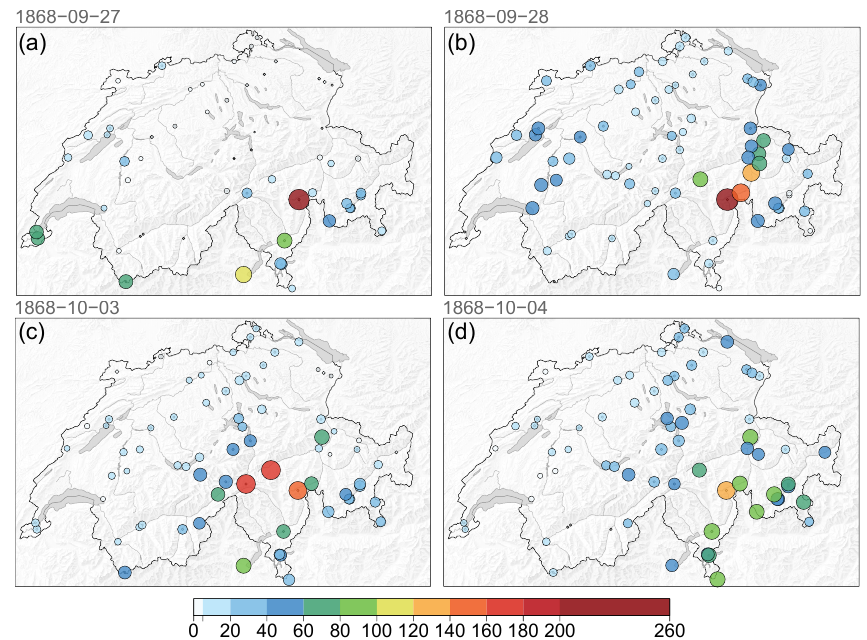
Figure 5. Observations of daily precipitation (mm24h − 1 from 05:40 LT) for (a) 27 September 1868, (b) 28 September 1868, (c) 3 Octo- ber 1868 and (d) 4 October 1868 as collected from Wolf (1868), Coaz (1869) and Luino et al. (2005). Note that not all daily values are available for all